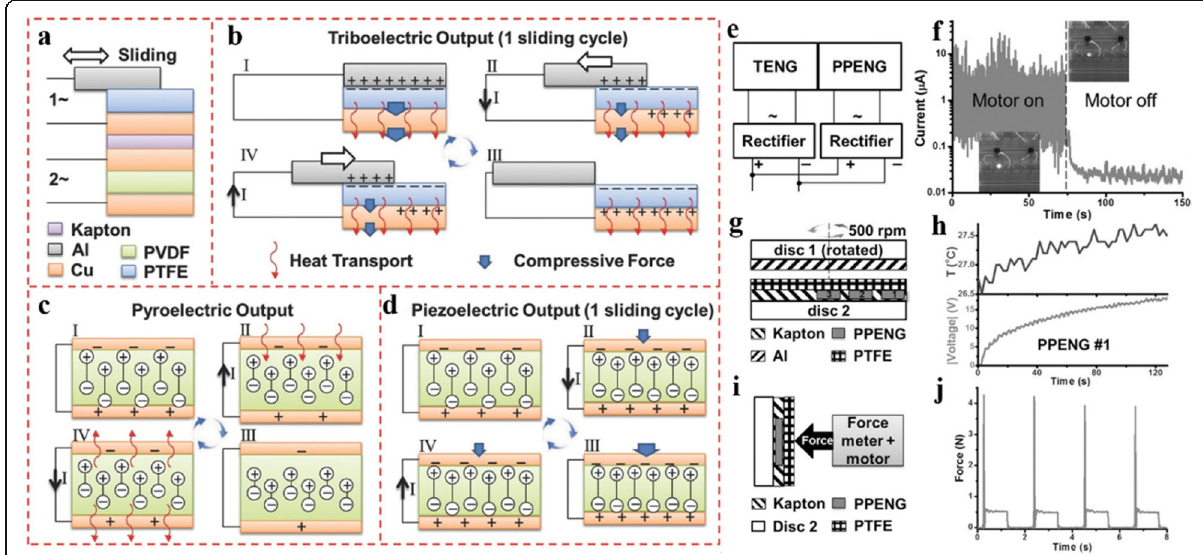
Fig. 11 a – d The structure and working principle of the tribo-, pyro-, and piezoelectric hybrid cell. e The circuit that hybridizes TENG and PPENG outputs. f The LED was lighted by the hybridized output current. g The schematic diagram of the structure used to demonstrate the temperature sensing. h The voltage and the temperature variation of the PPENG. i The schematic diagram of the measurement setup. j A force of approximately 0.5 N applied to the surface. Adapted with permission from ref. 56. Copyright 2015 John Wiley and